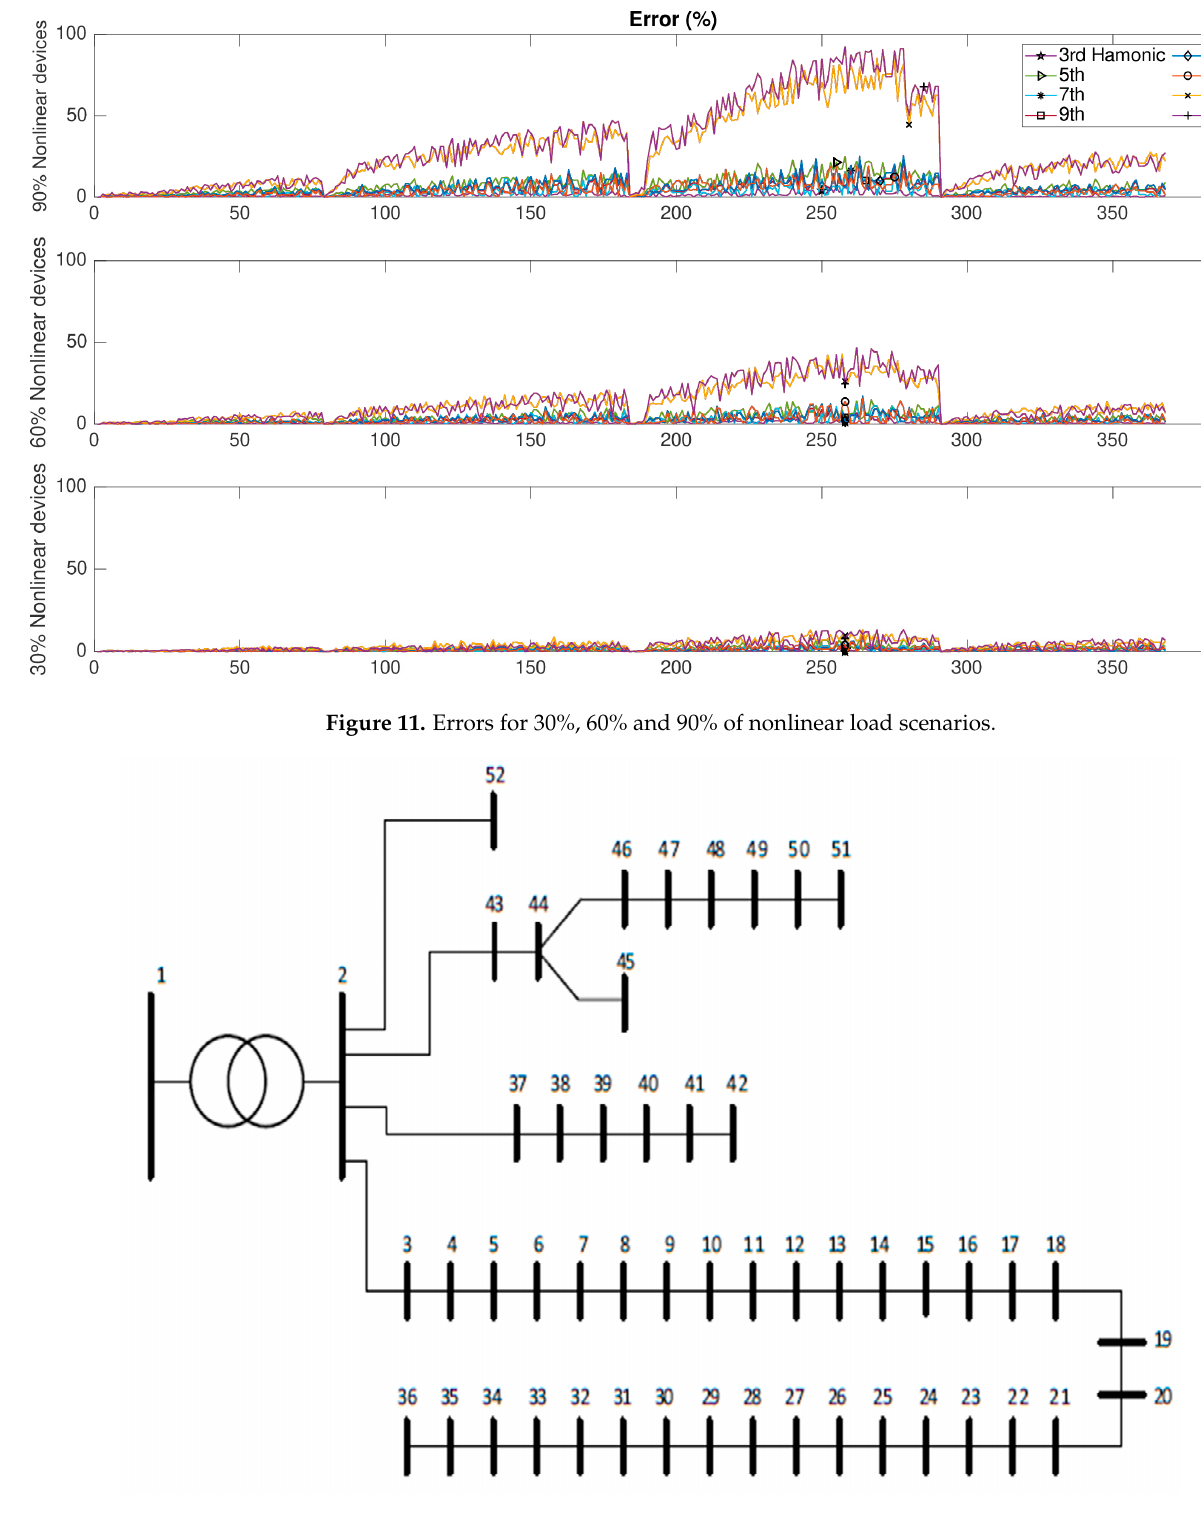
Figure 12. City centre LV network.